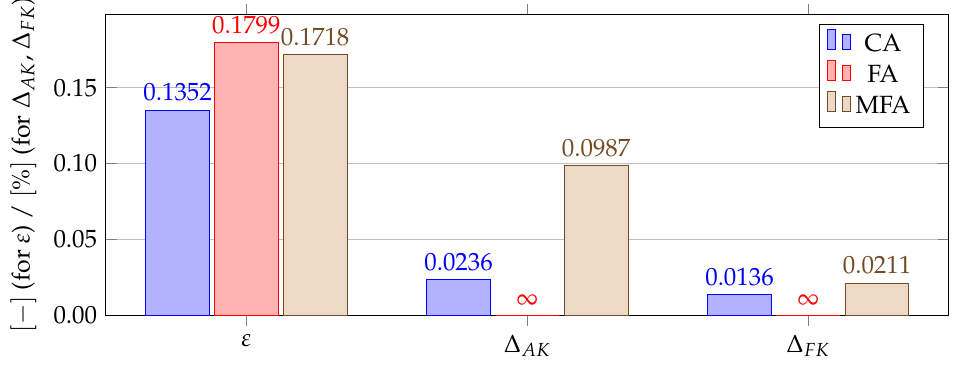
Figure 14. Comparison of shape parameters and error measures obtained using different algorithms for finding a good value of the shape parameter for test case 3, ∆ AF = 0.0082%. The value of ∞ means that the given algorithm led to an ill-conditioned interpolation matrix making the simulation